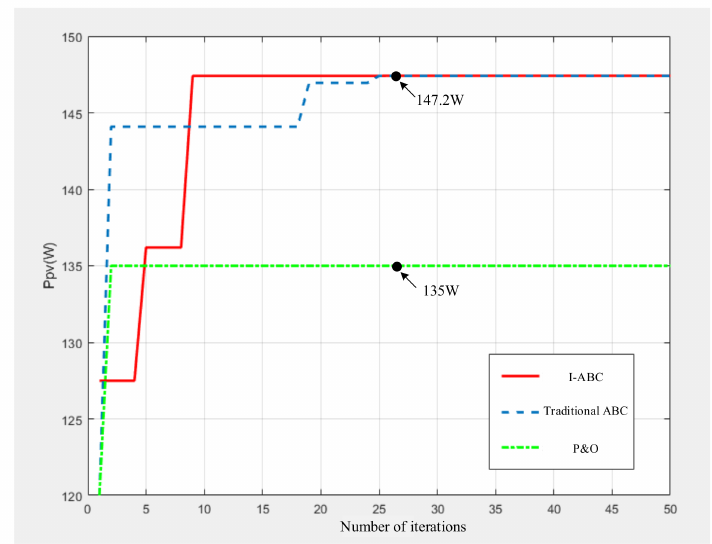
Figure 9. Comparison of simulation results for the MPPT in Case 2. P-V Characteristic Curve (intensity of insolation: 52SW/m 2 }